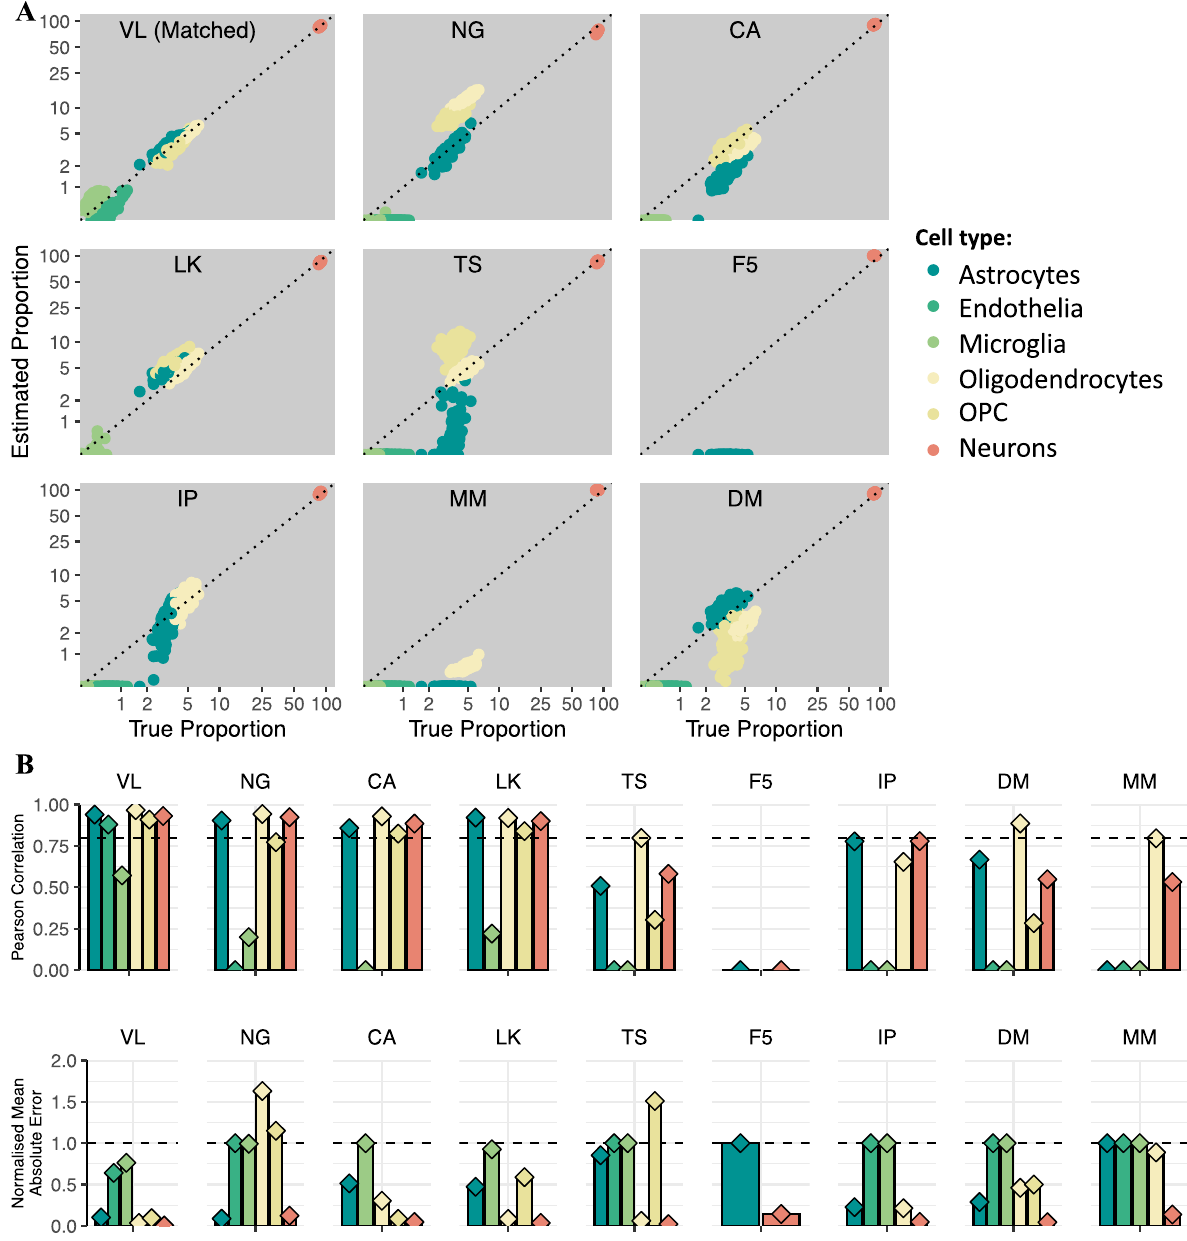
Fig. 2 Effect of signature choice on deconvolution accuracy. A Scatterplots of true and CIBERSORT-estimated proportions in VL-derived in silico mixtures, for nine different signatures. Matched: the signature and mixture were derived from the same dataset. Plot titles represent the signature used in deconvolution, as follows: VL Velmeshev, NG Nagy, CA Human Cell Atlas, LK Lake, TS Tasic, F5 FANTOM5, IP immuno-paned, MM mouse immuno- panned, DM darmanis. See the “ Methods ” section for further details about signatures. Dotted line: y = x . B Barplots of Pearson correlation ( r ) for all cell- types and signatures presented in ( A ). Dotted line: r = 0.8. C Barplots of normalised mean absolute error ( nmae ) for all cell-types and signatures presented in ( A ). OPC oligodendrocyte precursor cells. Dotted line: nmae =